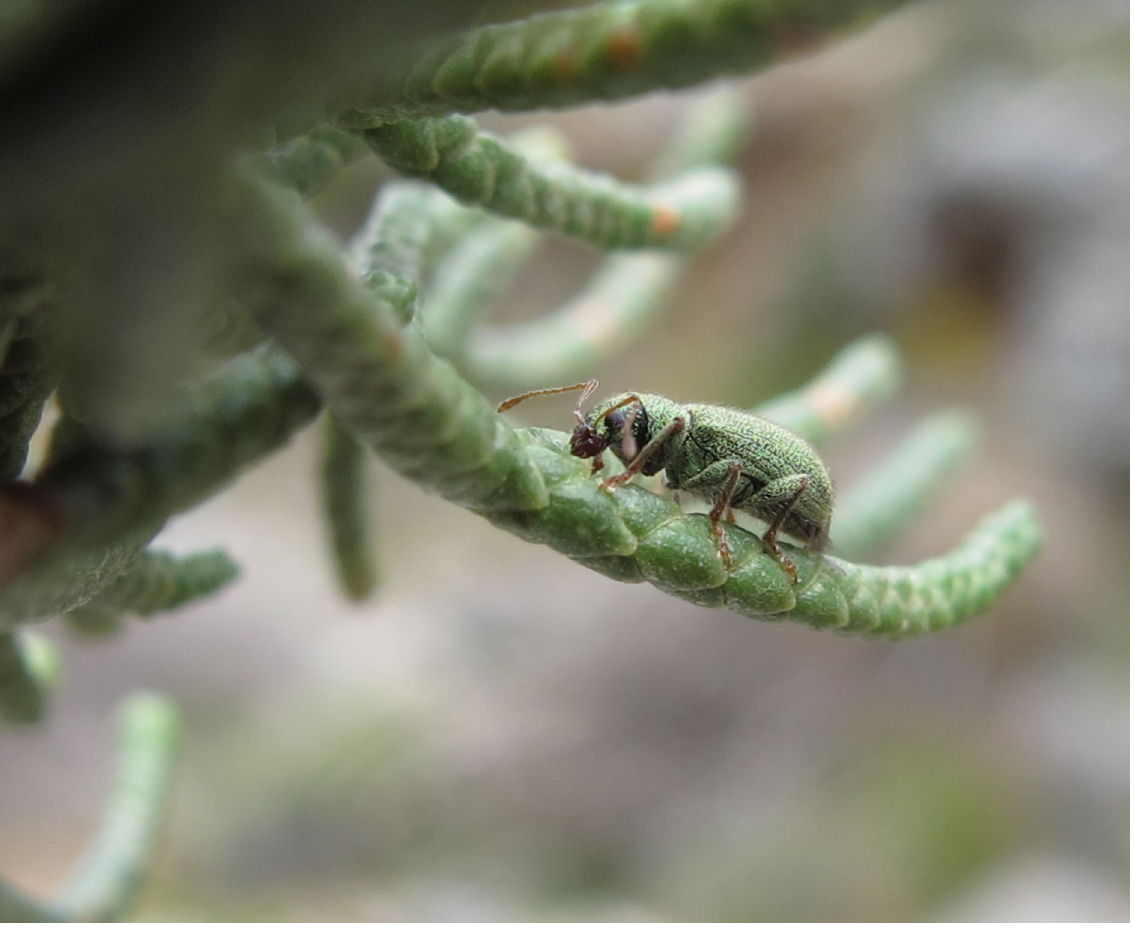
Fig. 5. Dichorrhinus creticus in April on Cupressus sempervirens , Chora Sfakion, 140 m a. s. l., Crete Island, Greece (photo: C.